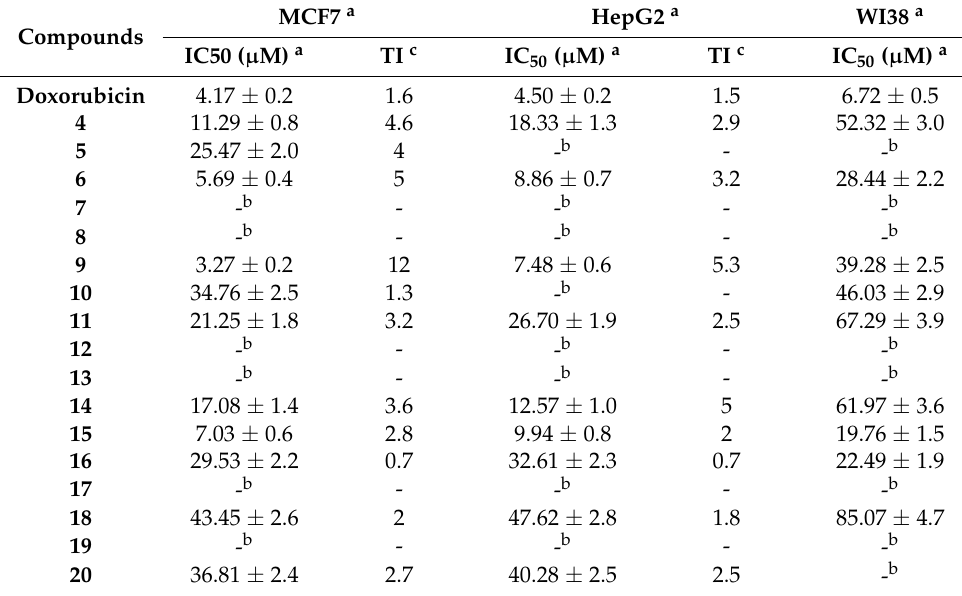
a The anticancer activities of the OSe compounds were assayed by the MTT method against HepG2, MCF-7, and WI-38 cells after twenty-four h of incubation with different concentrations of the OSe compounds. b Growth inhibition was not detected in the used concentration ranges (IC 50 > 100 µ M); c TI is the ratio of the IC 50 of primary WI-38 cells to the cancer (HepG2 or MCF-7) IC 50 for each compound. In general, the OSe cytotoxicity was more obvious against the MCF-7 cells than the HepG2 cells. In this context, OSe compound 9 was more cytotoxic than doxorubicin with IC 50 = 3.27 ± 0.2 against 4.17 ± 0.2 µ M, in the case of MCF-7, respectively. Furthermore, (2-((4-aminophenyl)selanyl)acetyl)tryptophan ( 6 ) and